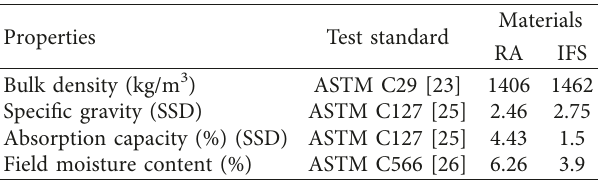
Figure 3: Gradation curve of recycled and IFS aggregate. Table 1: Material properties of coarse aggregate.